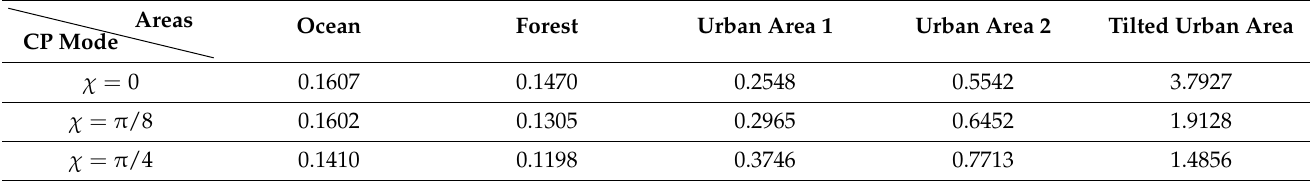
CP modes are with θ = π